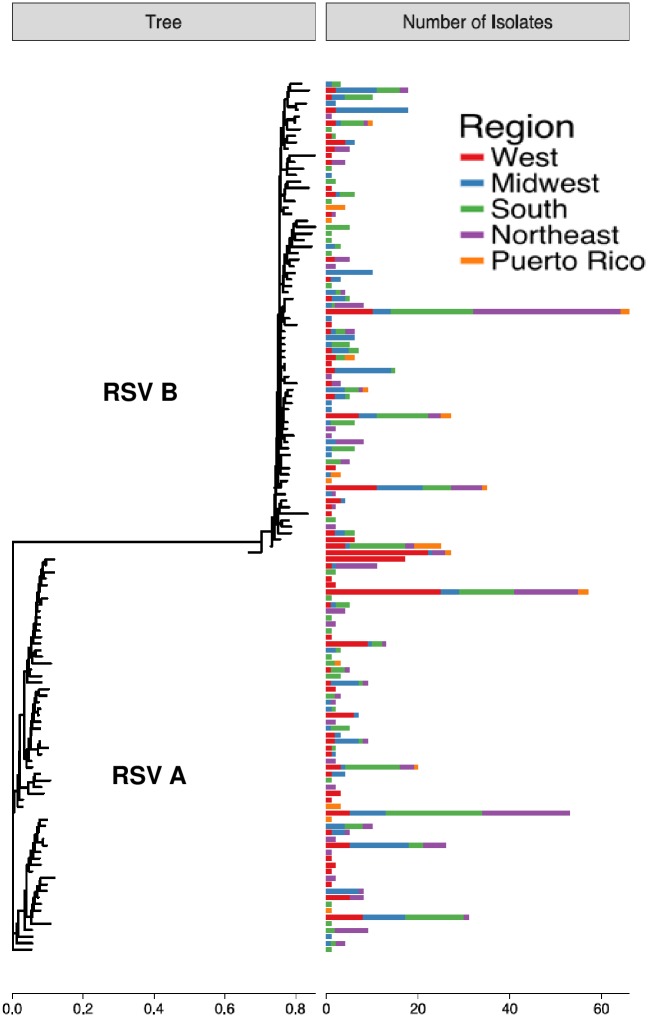
RSV A and B genotypes of 2016–17 OUTSMART samples by geographic region.The phylogenetic tree in the left panel was built using the representative G protein sequences from 97%-identity clusters, with the horizontal scale under the tree showing branch lengths derived from the dissimilarity metric. The corresponding bars in the right panel represent the number of samples in each cluster, with horizontal scale under the bar plot showing sample counts.